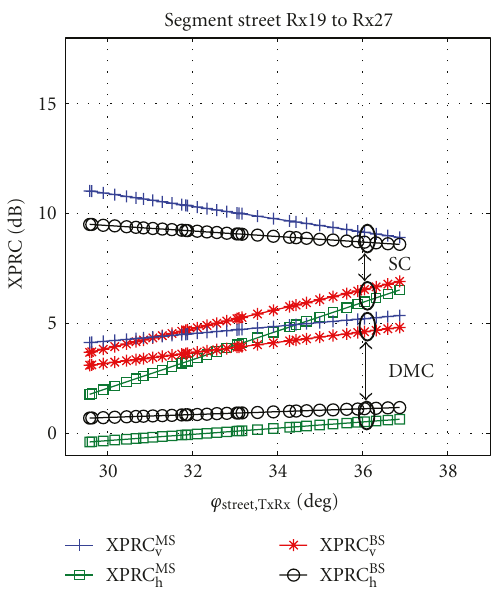
Figure 10: Change of the XPRCs dependent on the angle ϕ street,TxRx , Rx19 to